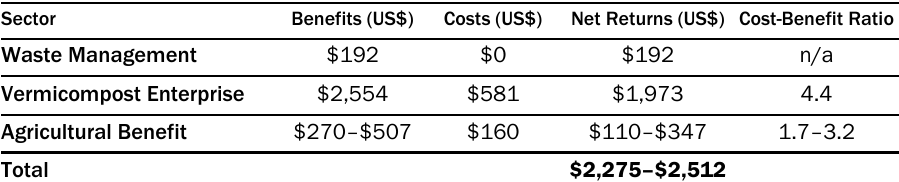
Table 6. Social Net Returns (US$ benefit/ton of